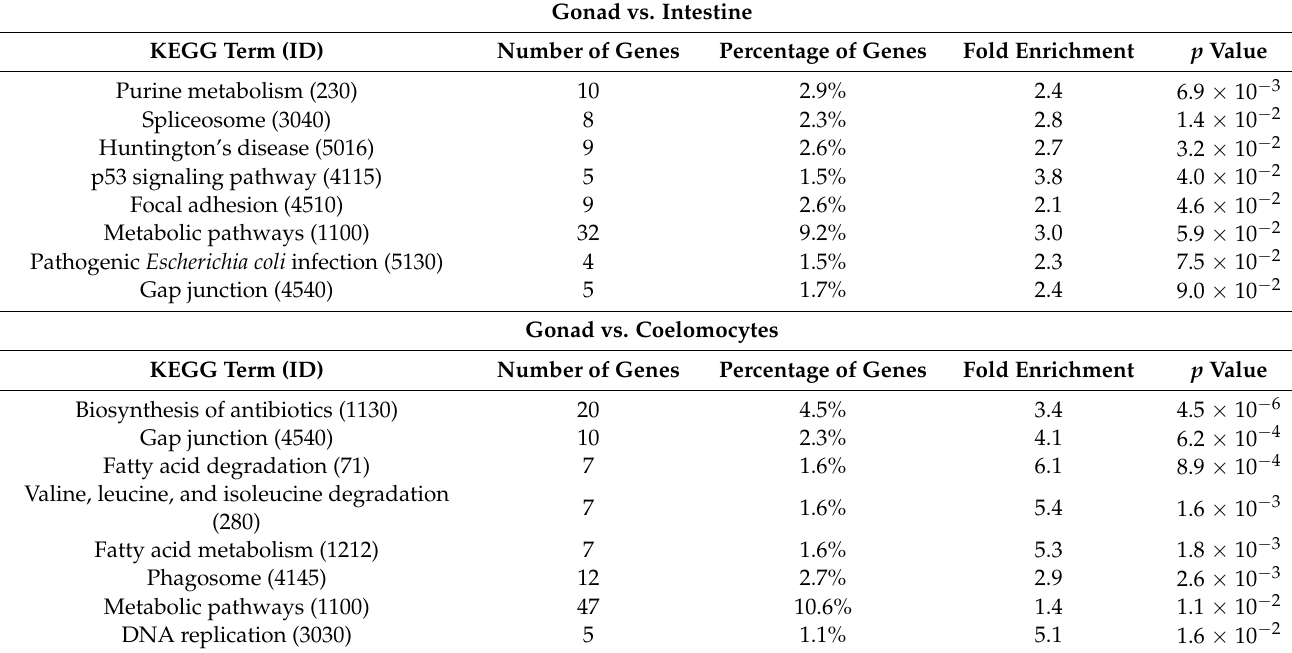
Table 3. The Top-16 KEGG pathways enrichment of up-regulated transcripts of gonad in the edible red sea urchin ( L. albus ). In comparison to intestine, purine metabolism was the most overrepresented and Biosynthesis of antibiotics compared to